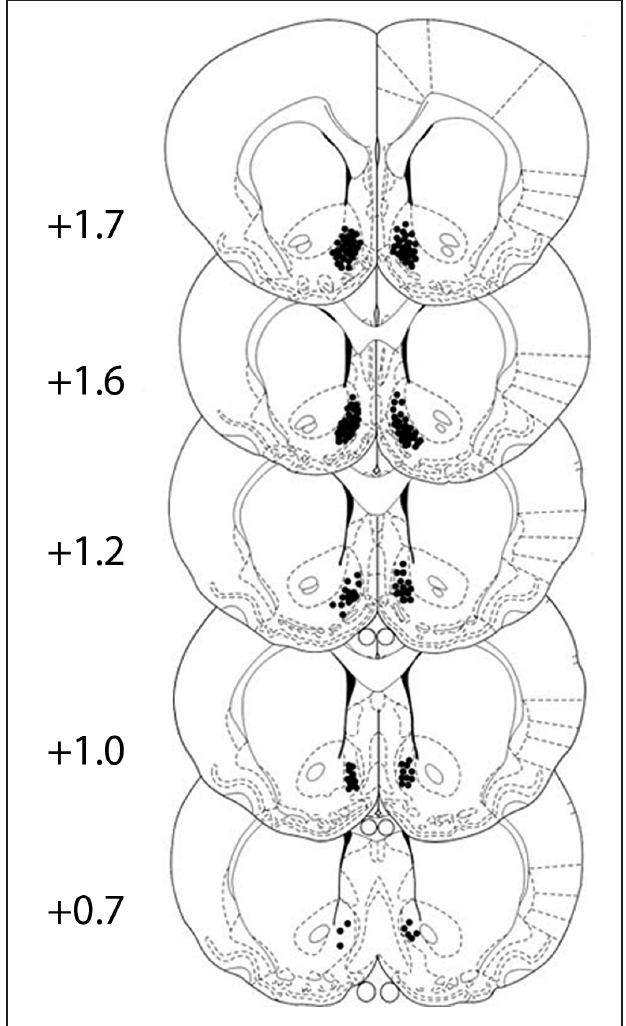
FIGURE 1 | All cannula placements in corresponding levels of the NAcSh. Numbers to the left indicate the approximate rostrocaudal plane posterior to bregma. Black dots show the location of the tip of the injector cannula for the rats. The figure is adapted from diagrams of a stereotaxic atlas of the rat brain (George Paxinos, 1996).